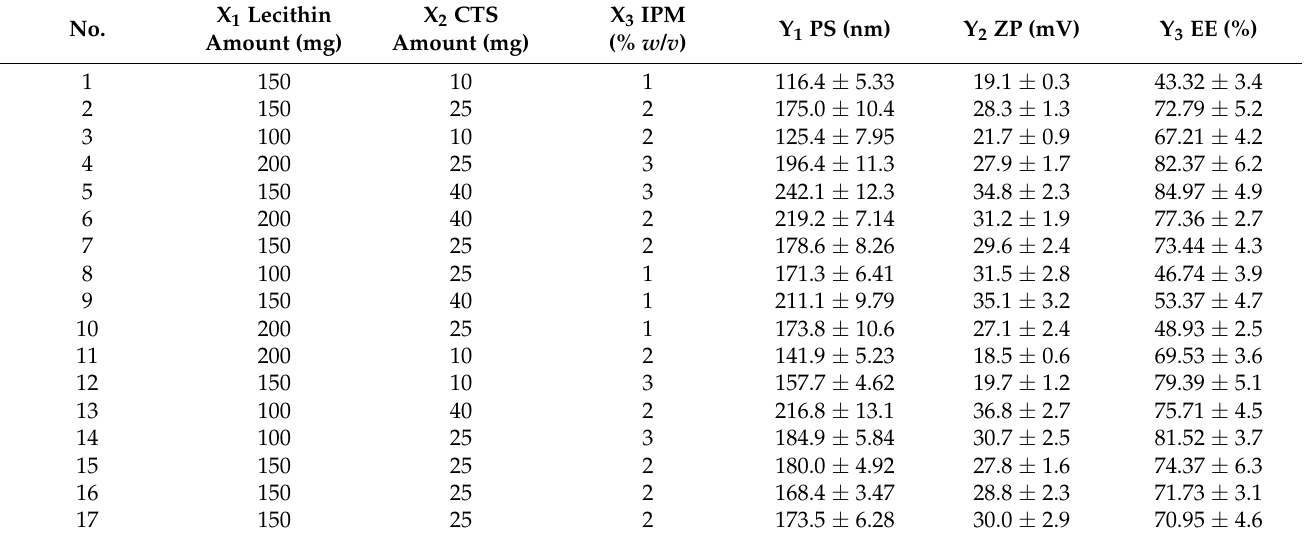
Table 2. BER-LC-CTS-NPs experimental runs, independent variables, and response variables according to the Box– Behnken